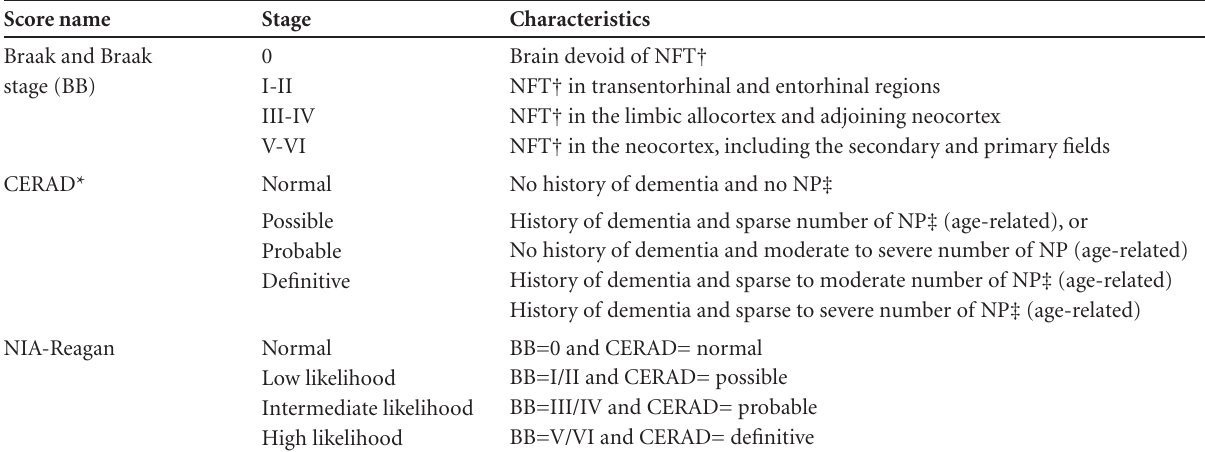
Table 1. Summary of the neuropathologic criteria of Alzheimer’s